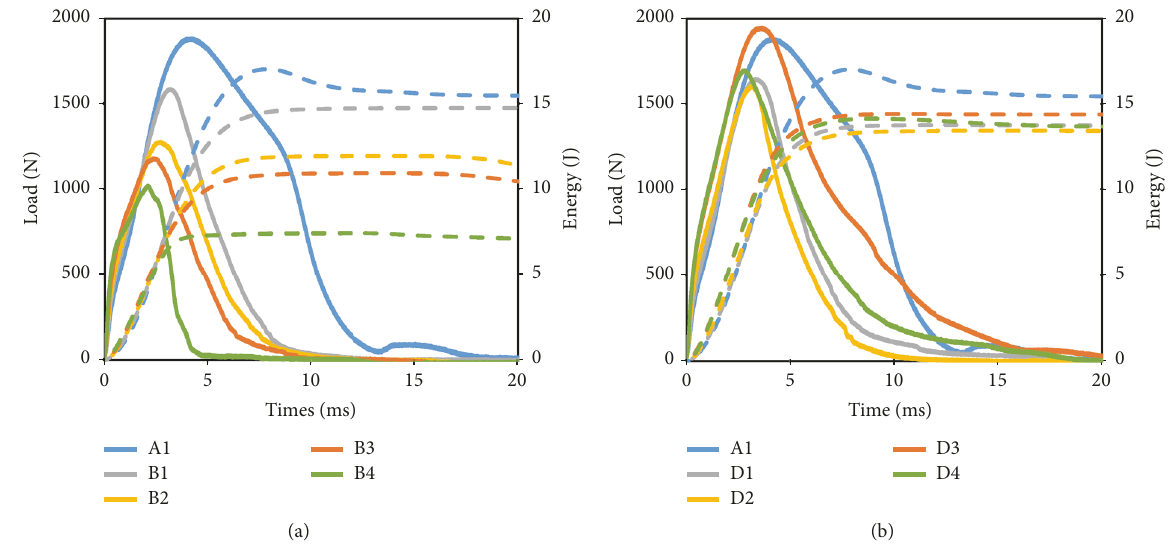
Figure 8: Load-energy-time graph of impact test: (a) composites types A and B; (b) composites types A and